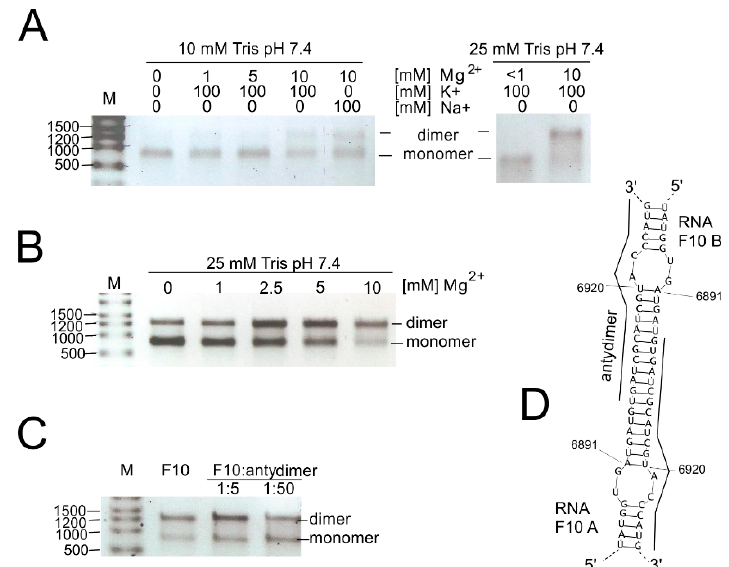
Figure 5. Dimerization of the F10 RNA, the 3 ′ -terminal region of the CVB3 genome. ( A ) Impact of ionic and buffer concentrations; ( B ) impact of divalent magnesium ions on dimerization process; ( C ) inhibition of homodimer formation in the presence of “antydimer” (DNA 18-mer), complementary to the F10 in the region of the potential dimerization site; and ( D ) computer predictions of the region responsible for F10-homodimer formation.